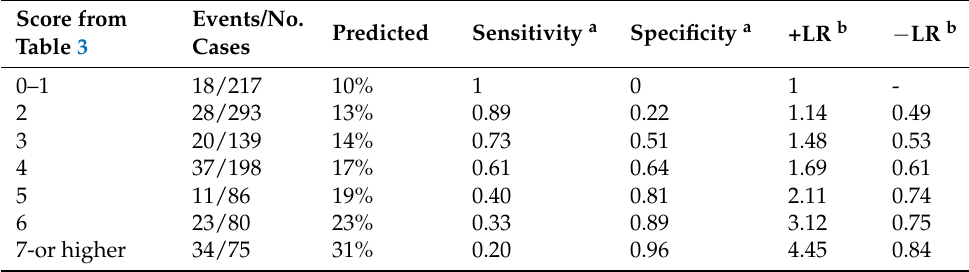
Table 4. Probability of severe complications after CRC surgery in relation to the sum score from Table 3. Score from Table 3